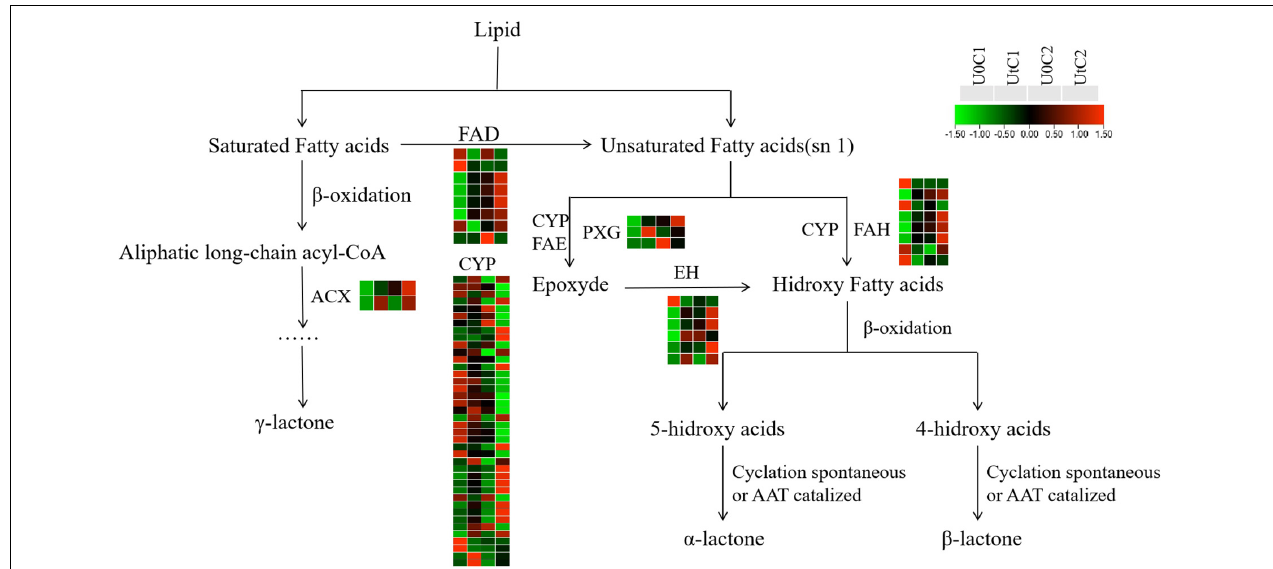
FIGURE 14 | Heatmap of differentially expressed genes (DEGs) related to lactone biosynthesis in Mingui 1 and Mingui 2. Heat maps were drawn using log2-transformed FPKM values.